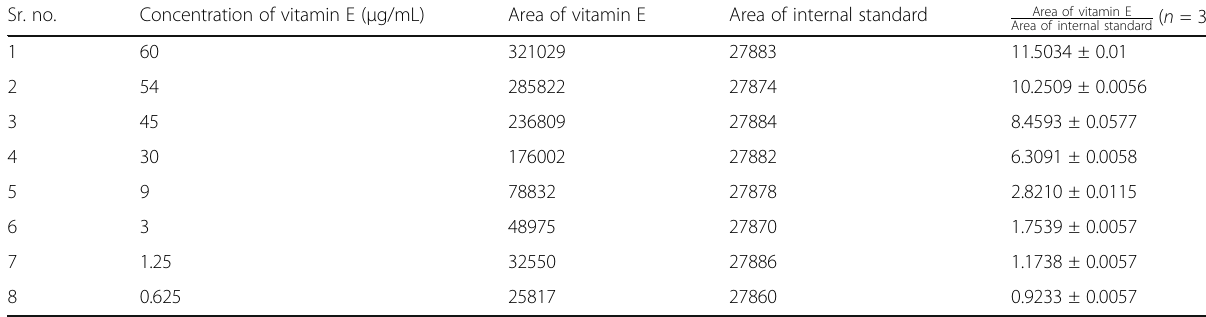
Table 4 Linearity parameters for developed bioanalytical method Sr.